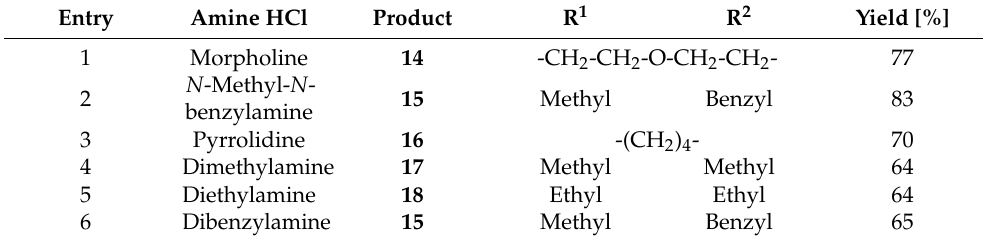
Table 2. Synthesis of aminoketones 14 – 18 via Mannich